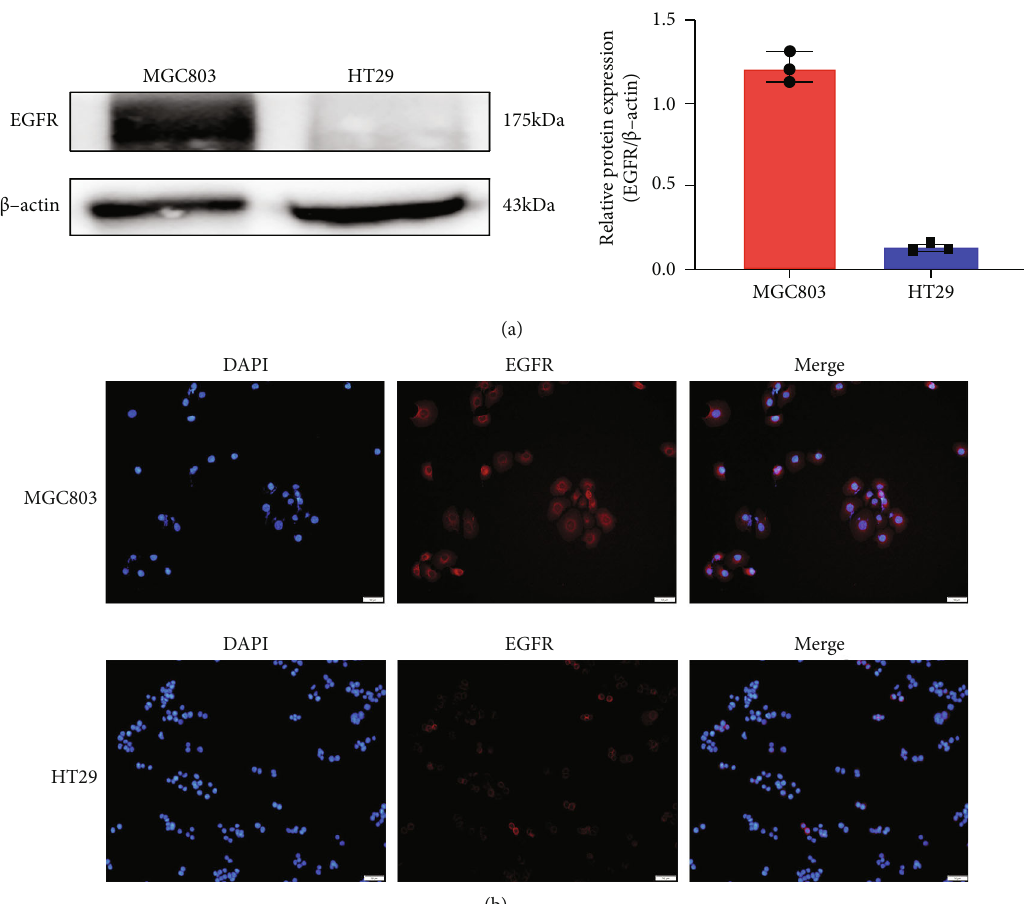
Figure 2: Evaluation of the EGFR expression in MGC803 and HT29 tumor cells. Western blots (a) and immuno fl uorescence of tumor cell (b) showed a higher EGFR expression level in MGC803 cells compared to HT29